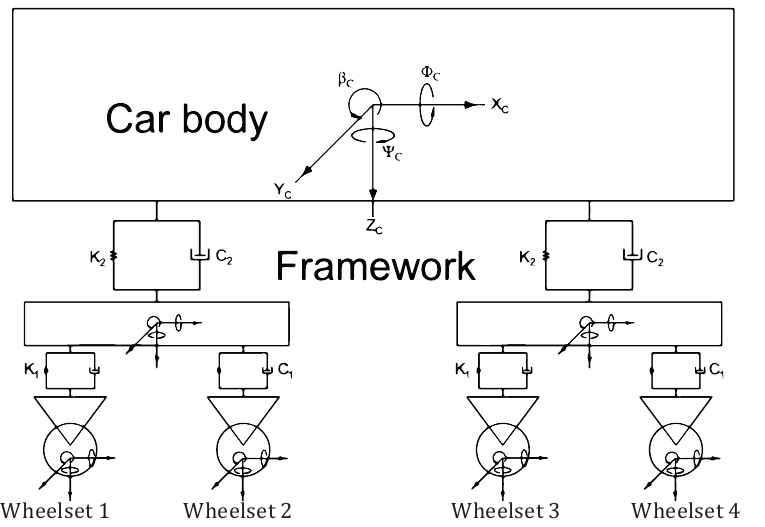
Figure 6. Side elevation of train model Wheelset 1 Wheelset 2 Wheelset 3 Wheelset